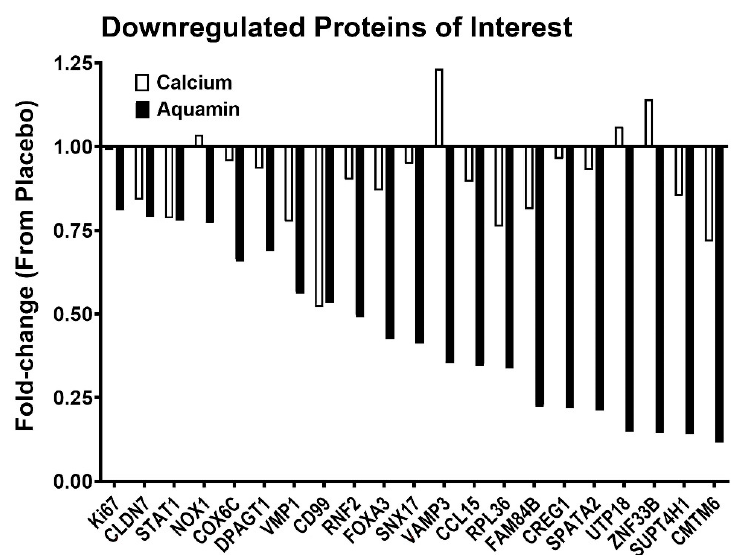
Figure 5. Downregulated proteins of interest. A fold-change value of each protein’s abundance ratio is presented in response to Aquamin ® and calcium interventions by comparing these to placebo. This pooled proteomic analysis was based on n = 10 subjects in each cohort.